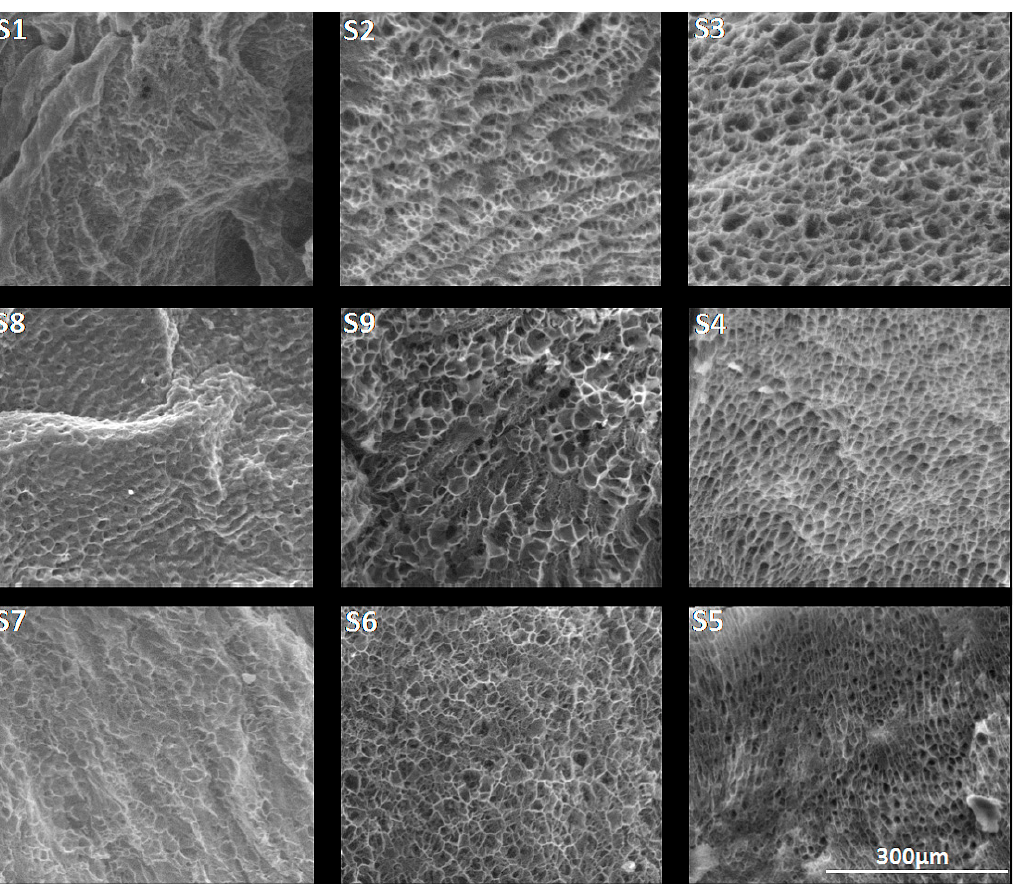
Figure 3. SEM images of the synthesized crosslinked citrate-salecan xerogels (magnitude 500×).